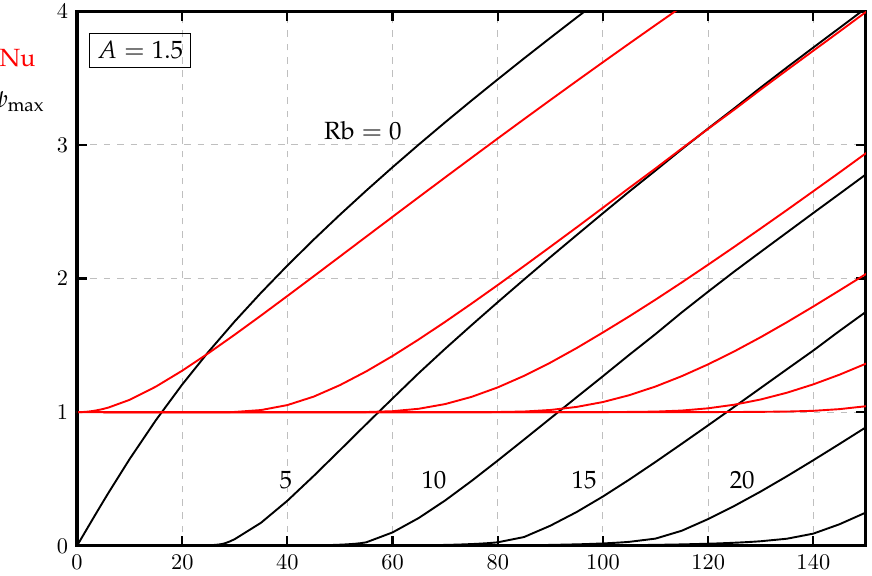
Figure 5. For an aspect ratio, A = 1.5, the variation with Ra of ψ max (black) and the Nusselt number, Nu (red) as Rb increases in steps of 5 from Rb = 0 to Rb = 25. Rb increases towards the right for ψ max and downwards for Nu.